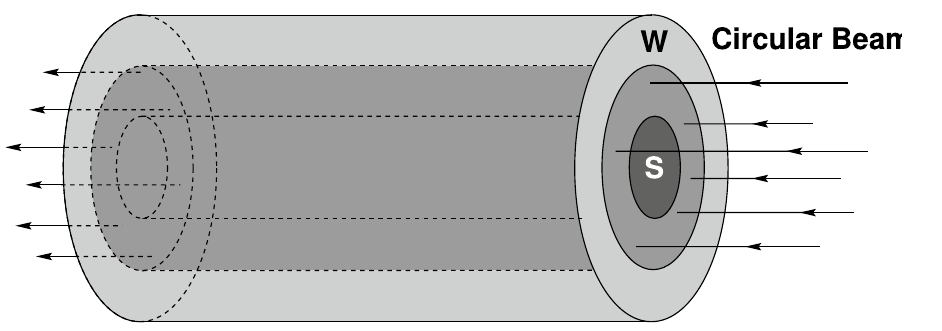
Figure 5. Beam–target set up of the LAPLAS scheme using a circular focal